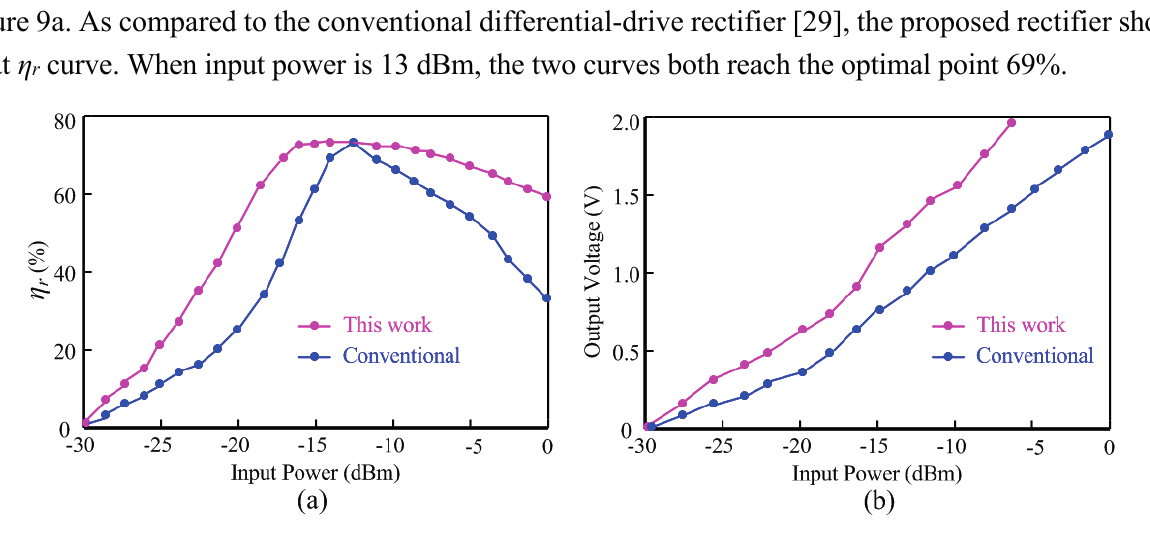
Figure 9. Performance comparison between conventional rectifier and this work: ( a ) power conversion efficiency and ( b ) output